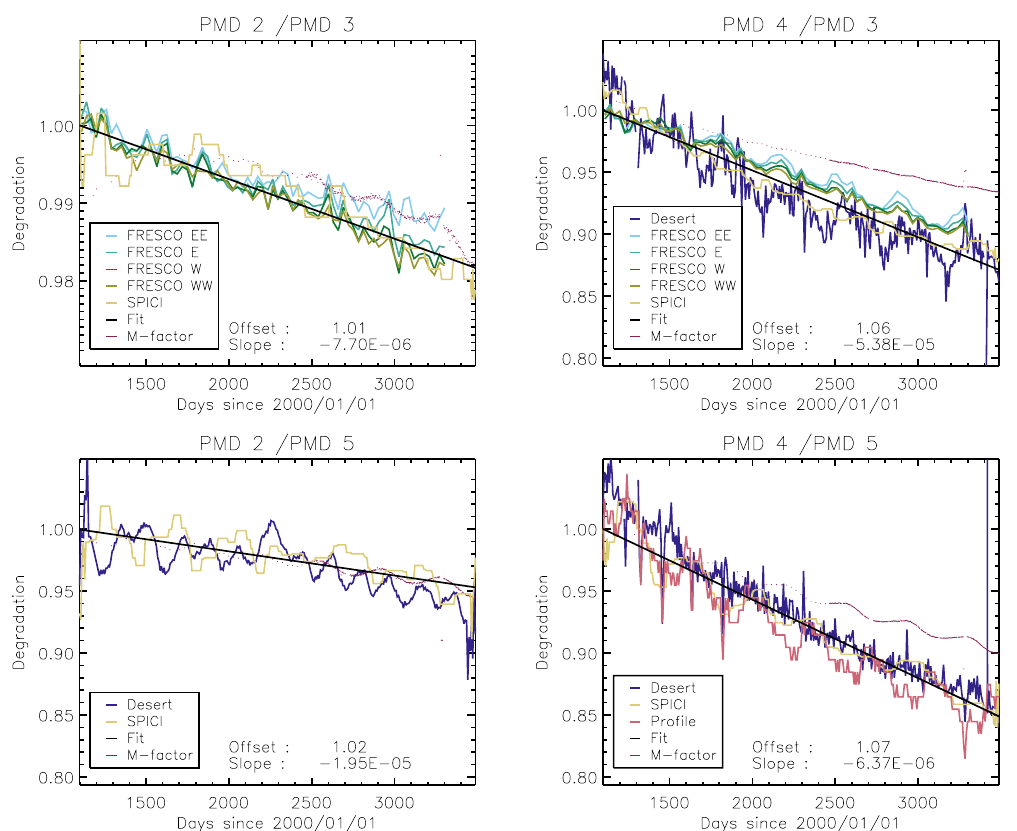
Fig. 3. Degradation for different PMD ratios (indicated at top) and for different methods (colour-coded, detailed description of methods in the main text) as a function of time. Indicated at the bottom of each figure are the components of a linear fit to the degradation, which can be used for degradation correction. Note the use here of PMD 4/PMD 5 instead of PMD 5/PMD 4 for consistent decrease of the ratio over